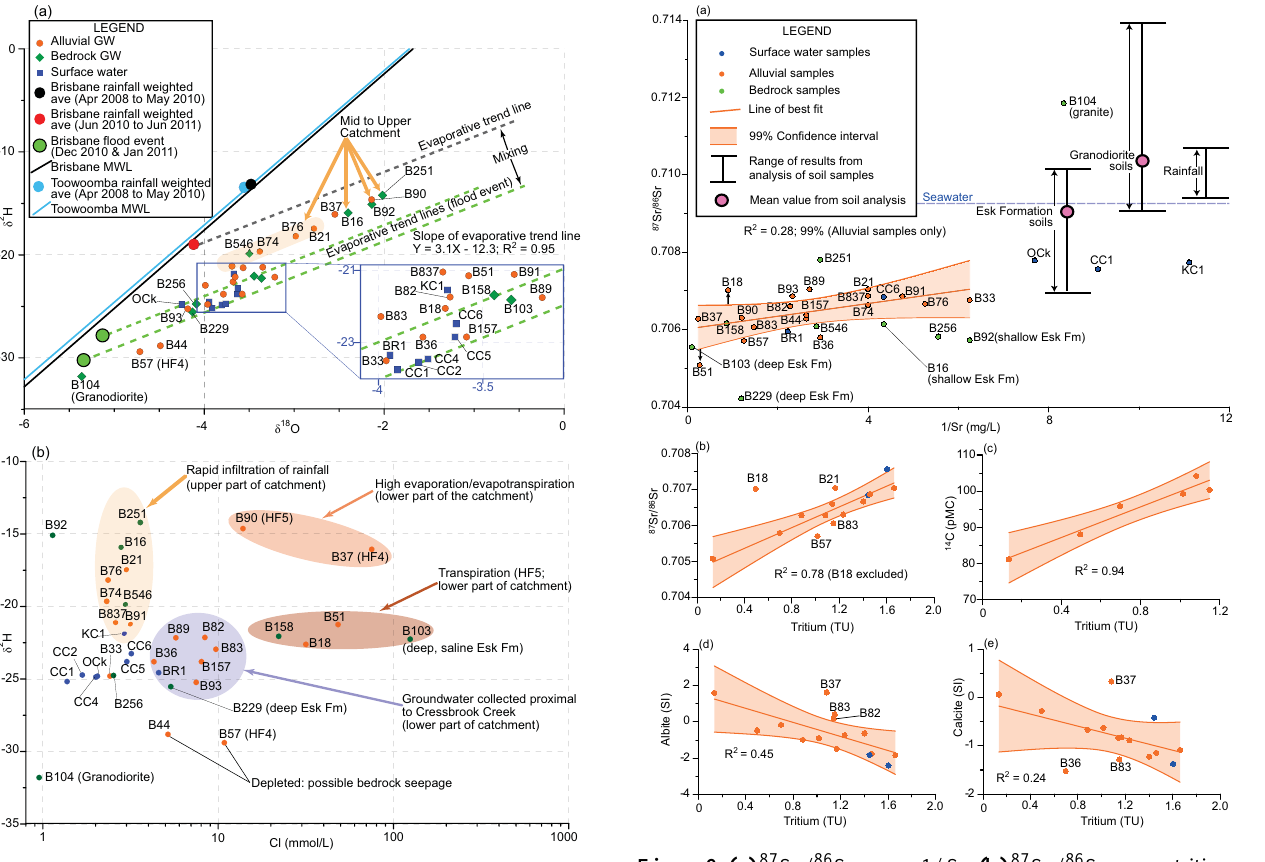
Figure 8. (a) δ 2 H versus δ 18 O values (‰ Vienna Standard Mean Ocean Water, VSMOW) compared to flood rainfall (ANSTO) and the meteoric waterline for Brisbane and Toowoomba (Crosbie et al., 2012); and (b) semi-log plot of δ 2 H (‰ VSMOW) versus Cl.